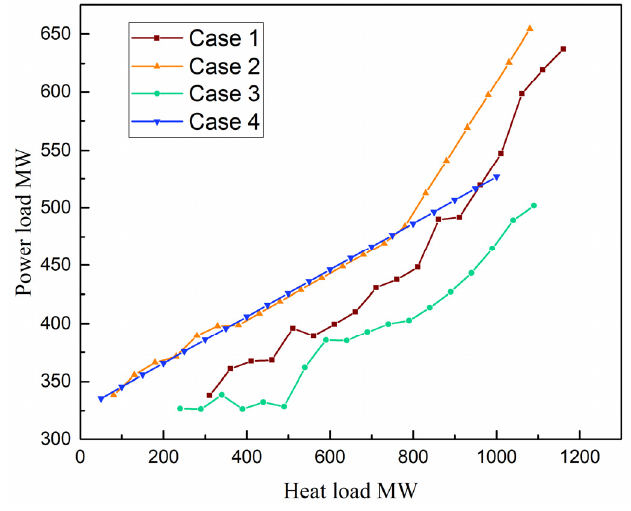
Figure 11. The optimized minimum lower limit of power load in different cases.